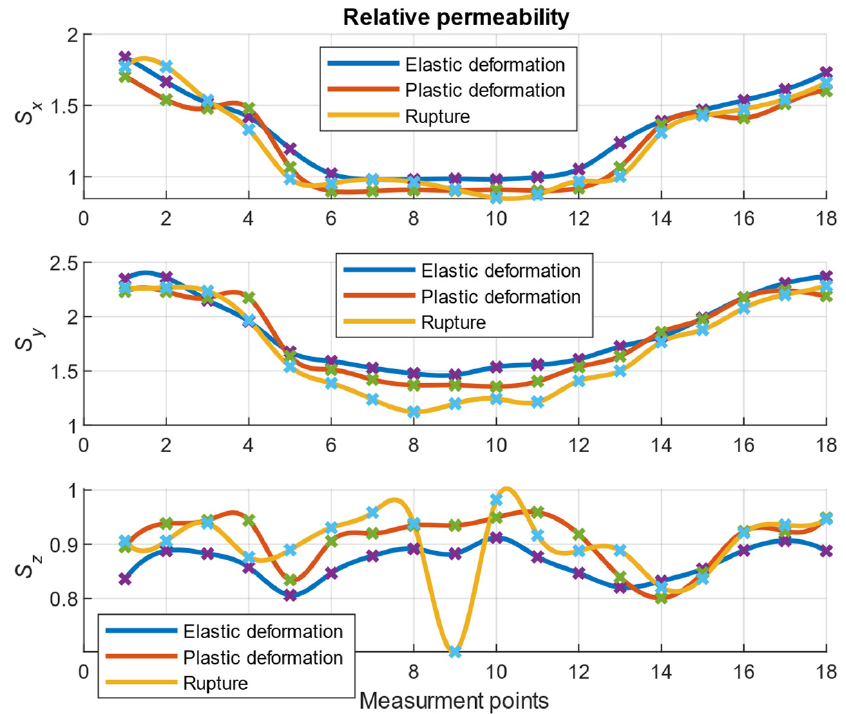
Figure 9. Summary of the changes in the parameter related to the magnetic permeability of the specimen for each axis and different states of stress at successive points on the specimen’s surface (measurement points).